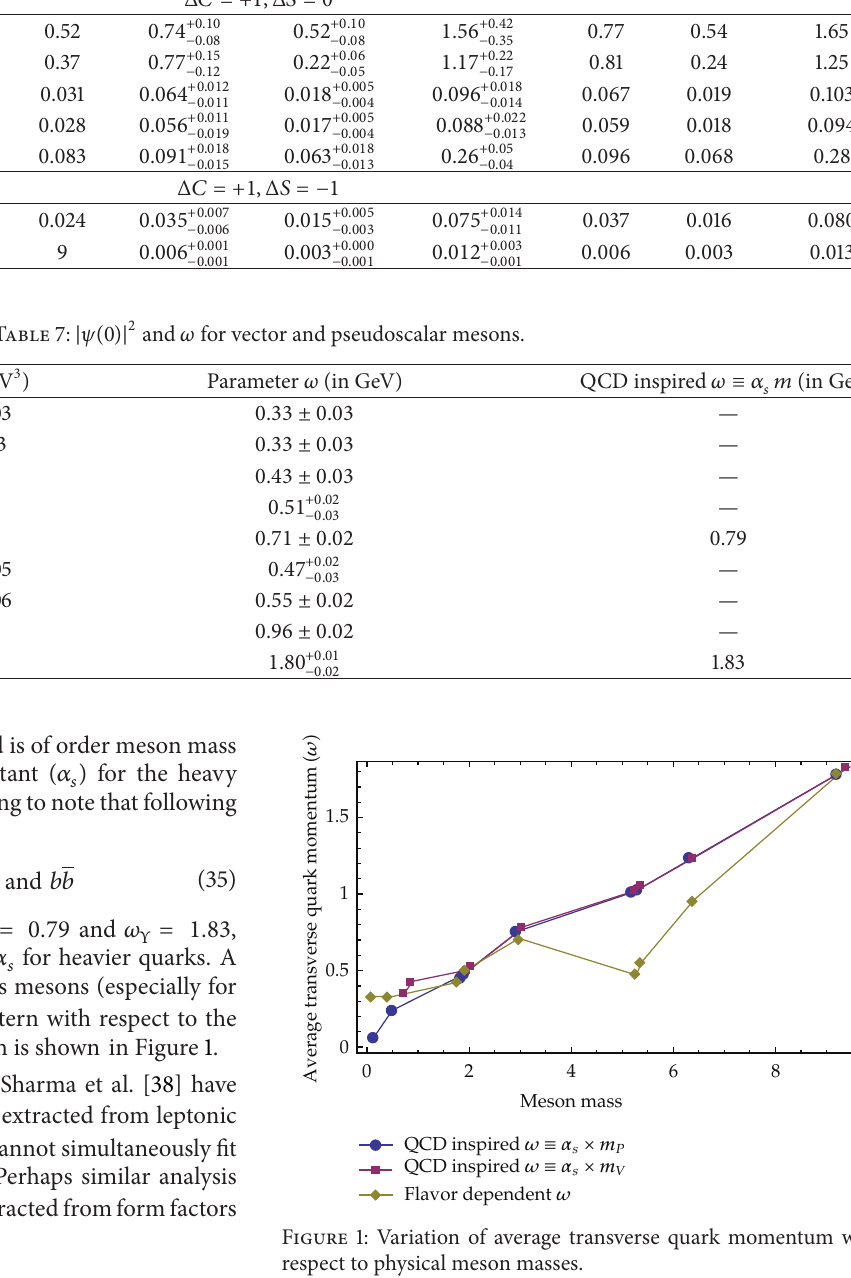
Table 2. Contributions from the Helicity amplitudes 𝐻 0 and